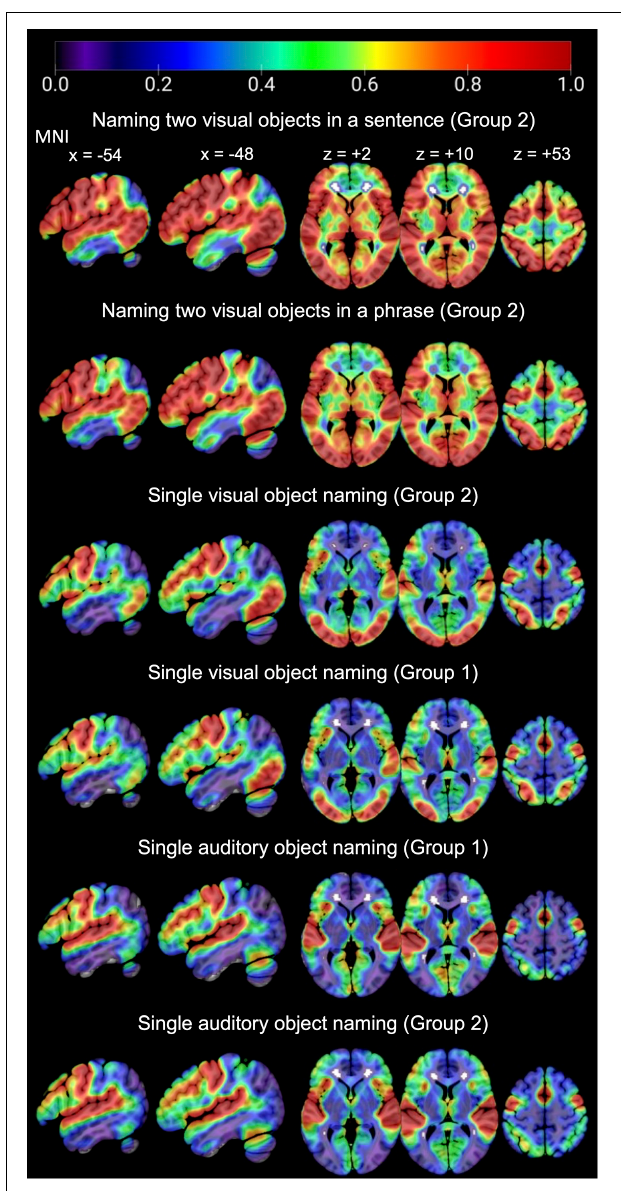
FIGURE 5 | Consistency of activation across the whole brain, for each task of interest in each group.